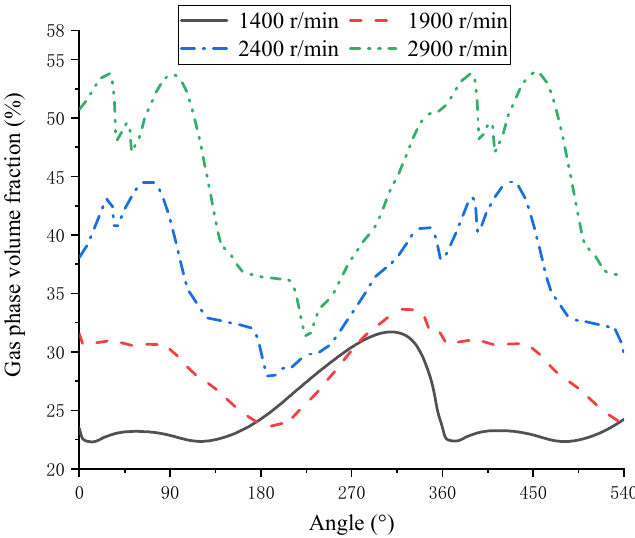
Figure 9. Gas volume fraction at different rotating speeds.